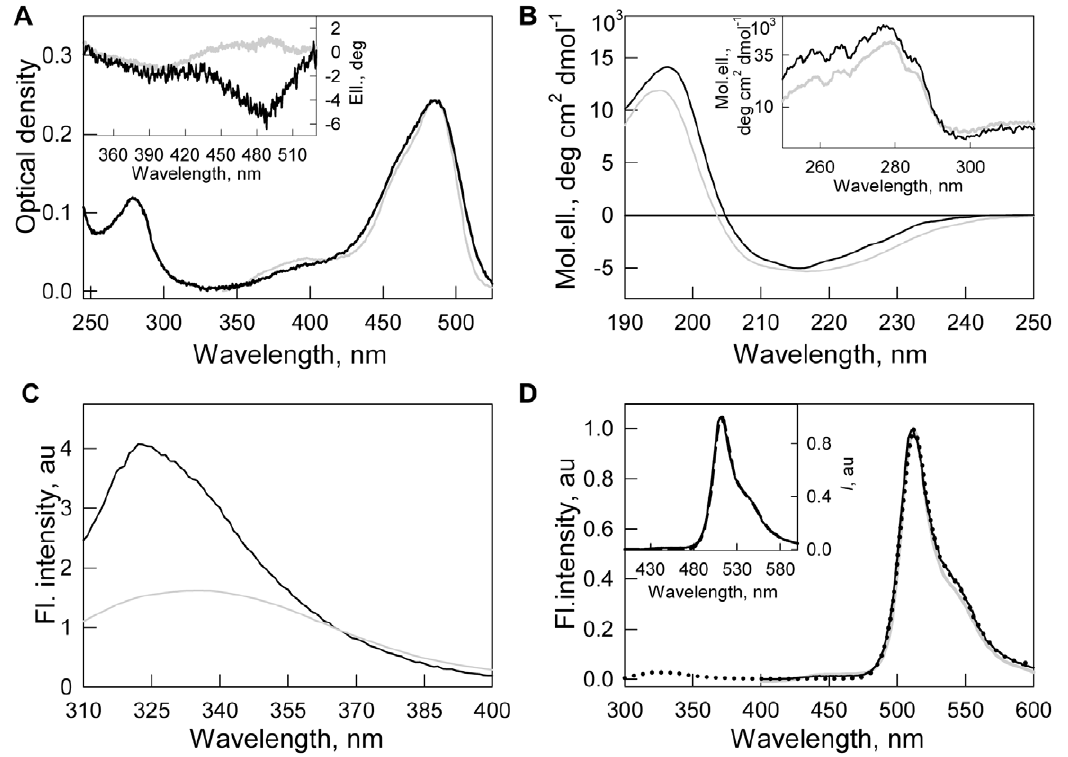
Figure 2. Physicochemical characteristics of sfGFP (black line) in comparison with EGFP (gray line). ( A ) Absorption spectra in UV- and visible spectra regions, (inset to A ) CD in visible-UV region. ( B ) CD in far-UV and near-UV (inset to B ) regions. ( C ) Intrinsic fluorescence spectra at excitation wavelength of 297 nm. ( D ) Green chromophore fluorescence of both sfGFP and EGFP at excitation wavelength of 390 nm (solid black and gray lines, respectively). Fluorescence spectrum of sfGFP at excitation wavelength of 295 nm (dotted line) is also shown. Fluorescence spectra of sfGFP at excitation wavelengths of 390 nm (solid line), 485 nm (dashed line), corresponding to absorption of neutral and anionic chromophore, are presented on inset to D